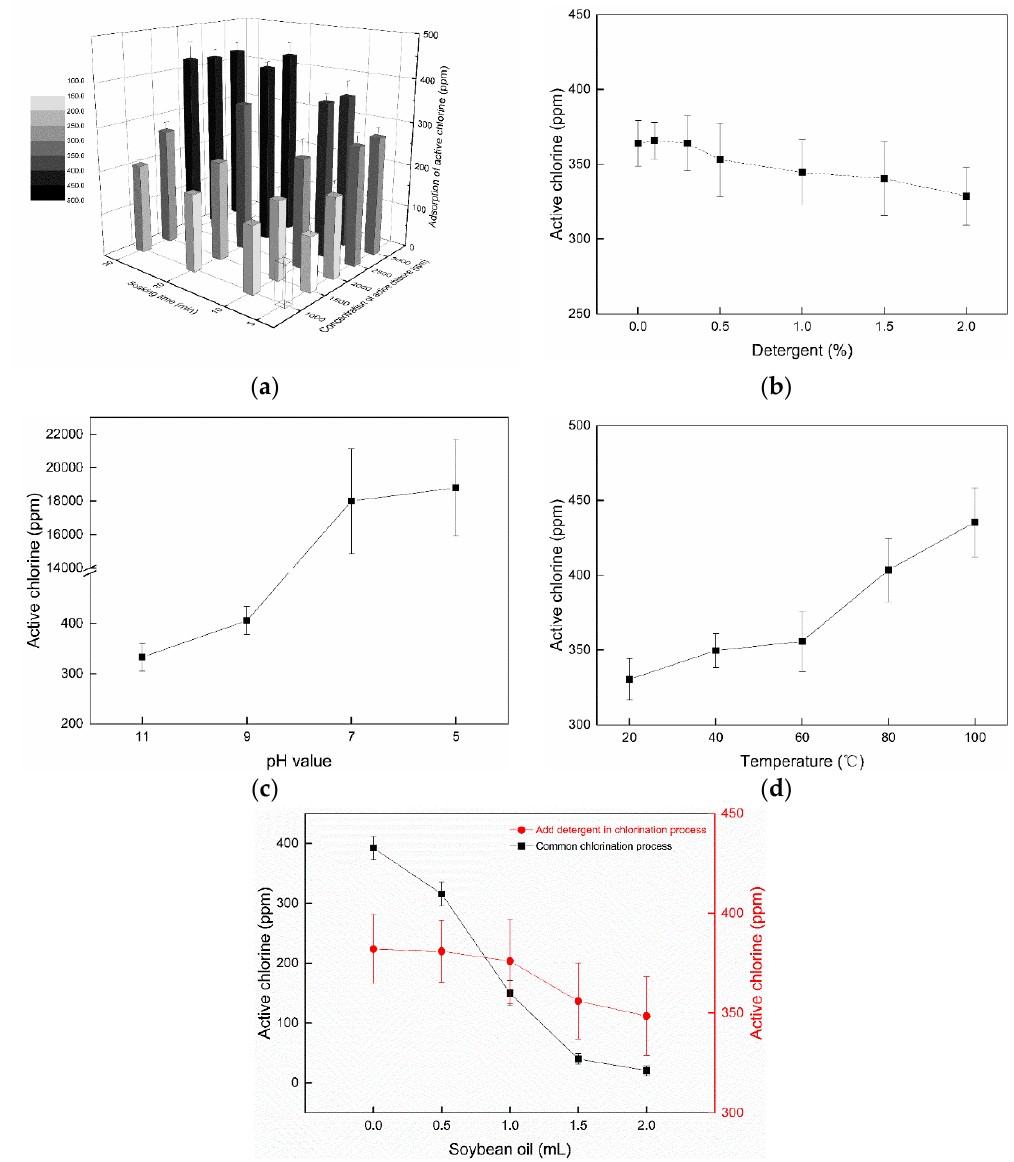
Figure 7. Recharging efficiency affected by different bleaching conditions. ( a ) Soaking time and concentration of bleach solution; ( b ) Addition of a detergent; ( c ) pH of bleach solution; ( d ) Temperature of bleach solution; ( e ) Soybean oil on fabrics. Symbol: Mean ± SD.